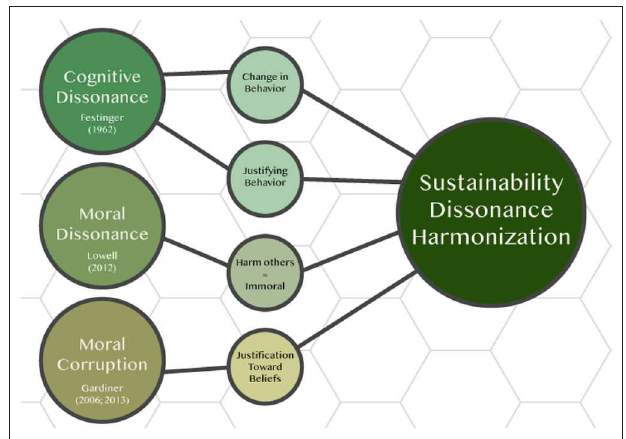
FIGURE 1 | The derivation of sustainability dissonance harmonization (SDH),